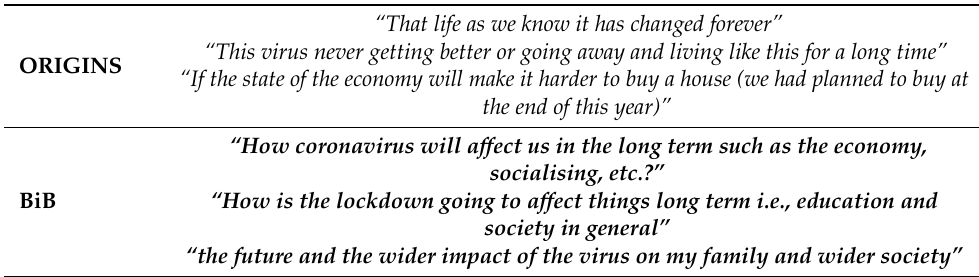
Table 5. Long term concerns: Sample responses.